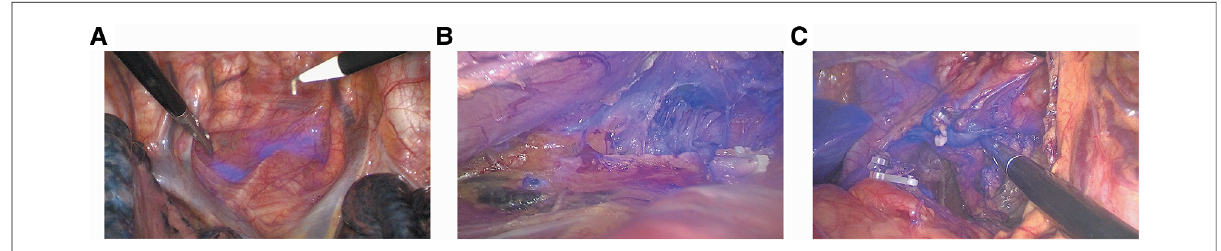
FIGURE 2 ICG-NIR image-guided identi fi cation of esophageal lymph nodes. ( A ) ICG + periesophageal lymph nodes; ( B ) ICG + paralaryngeal recurrent nerve lymph nodes and ICG + lymphatic tract; ( C ) ICG + left gastric lymph nodes and ICG + lymphatic